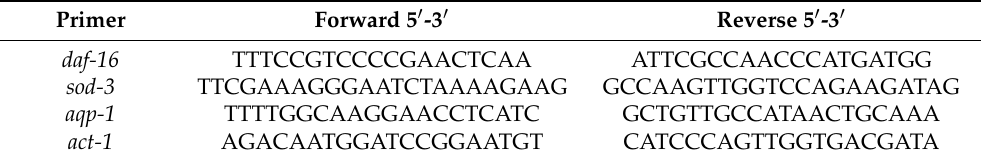
Table 1. The sequence of RNA